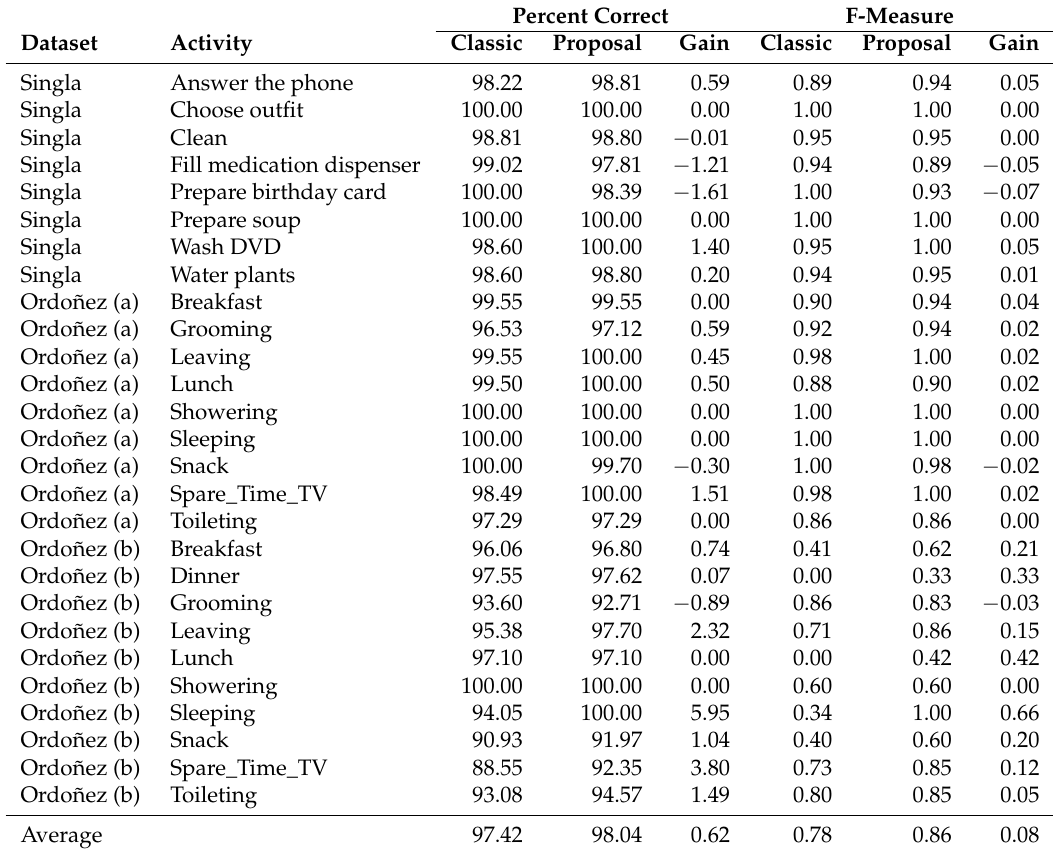
Table 12. Global classification performance on the Singla and Ordoñez